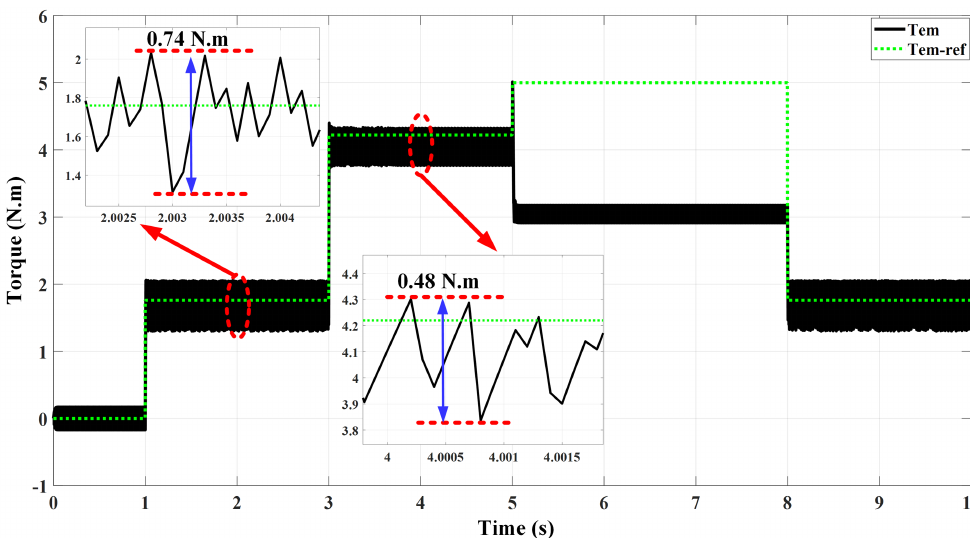
Figure 8. The DTSFC algorithm with successive steps of the reference torque for testing torque